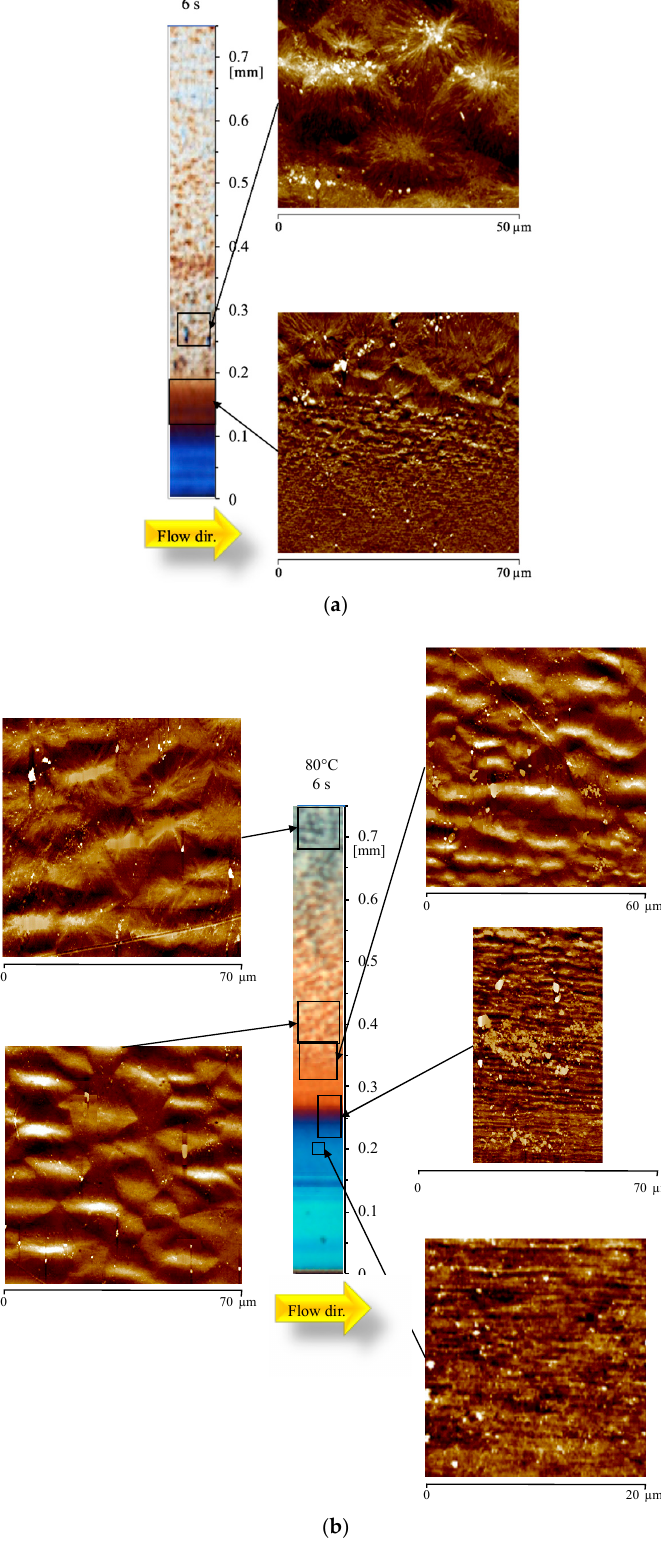
Figure 8. Optical micrograph and AFM height maps, at different distances from the sample surface, of the sample ( a ) 150-6 and ( b ) 80-6 (at 15 mm downstream the gate).